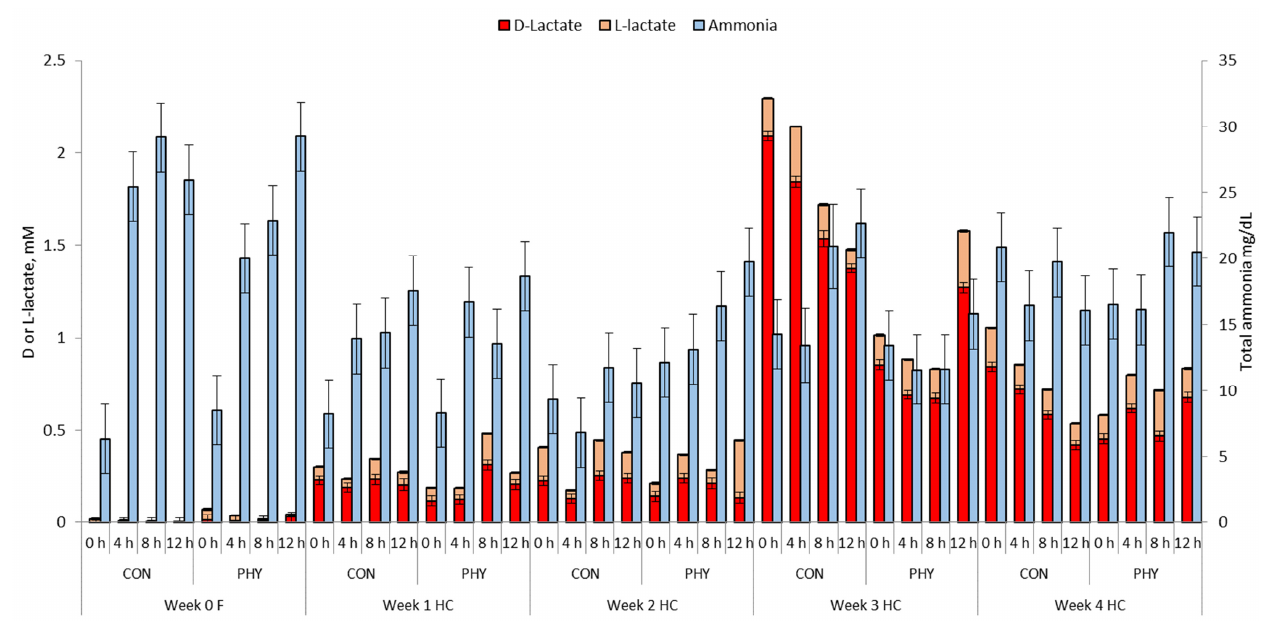
Figure 3. Variation of ruminal D-lactate, L-lactate (mM), and total ammonia concentration (mg/dL) from 0 to 12 h post-feeding in cows fed either all-forage (F) or a high concentrate (HC), without supplementation (CON) or supplemented (PHY) with a phytogenic feed additive based on L-menthol, thymol, eugenol, mint oil ( Mentha arvensis ) and cloves powder ( Syzygium aromaticum ). p -Values: D-lactate, Time = 0.99, Trt = 0.42, Diet < 0.01, Time × Trt × Diet × Week < 0.01; L-lactate, Time = 0.63, Trt = 0.60, Diet < 0.01, Time × Trt × Diet × Week < 0.05; Total ammonia, Time < 0.01, Trt = 0.90, Diet < 0.01, Time × Trt × Diet × Week < 0.01.